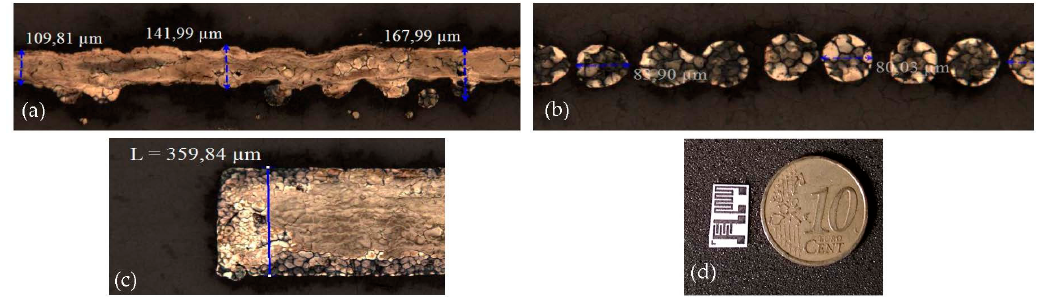
Figure 1. Droplet spacing: a line printed with ( a ) 40 um; ( b ) 70 um spacing; ( c ) five lines printed with 68 um droplet spacing; ( d ) photograph of the device with a 0.10 euro coin for scale. The optical microscope images were acquired with a dark